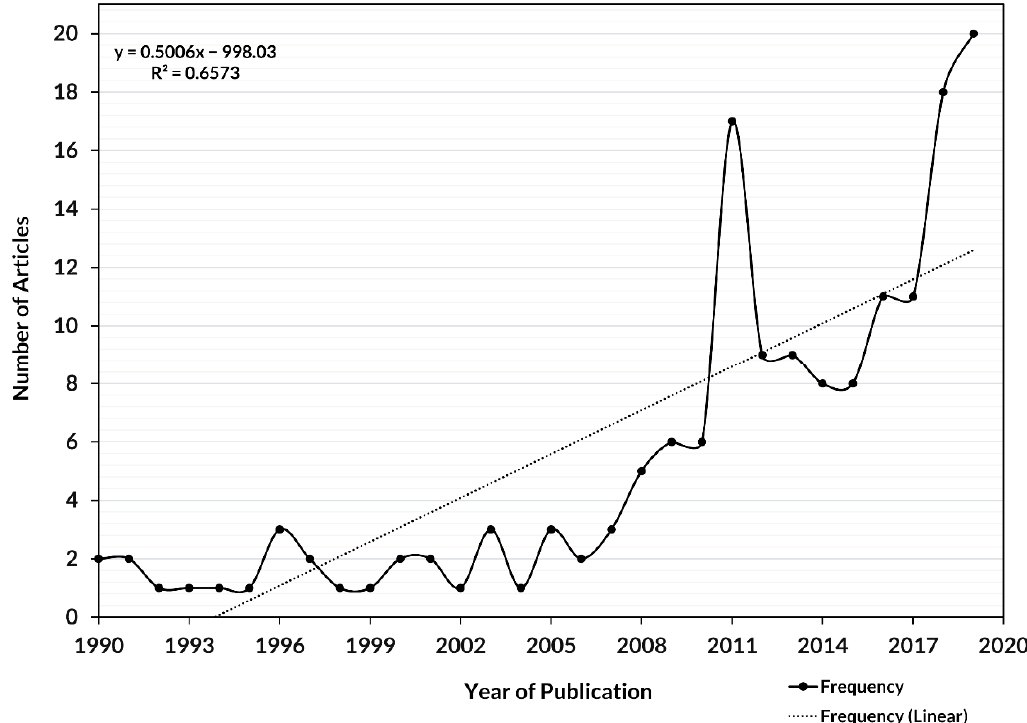
Figure 2. The trend in the publication of forest studies (1990–2019).